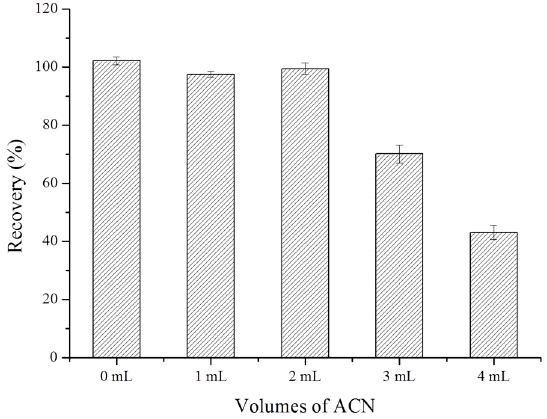
Figure 3. Influence of different washing solvent volumes (0, 1, 2, 3, and 4 mL) on BPA recoveries for PPMIP.